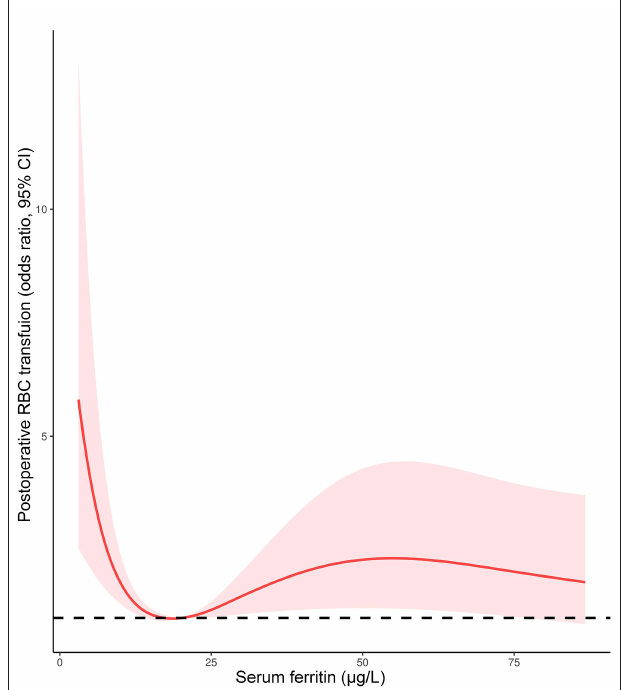
FIGURE 5 | The restricted cubic spline model for serum ferritin and postoperative RBC transfusion.